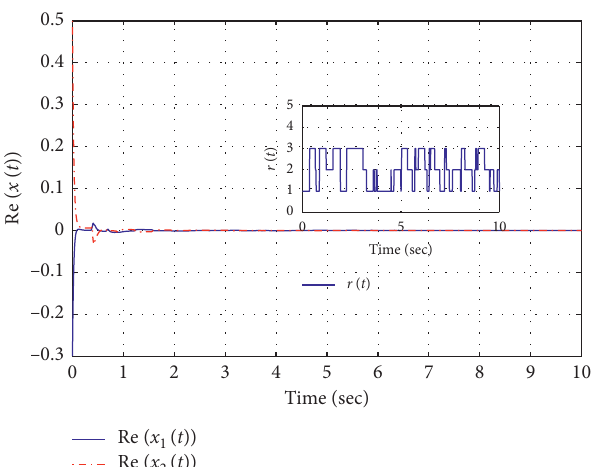
Figure 5: The imaginary part of the state without u ( t ) .